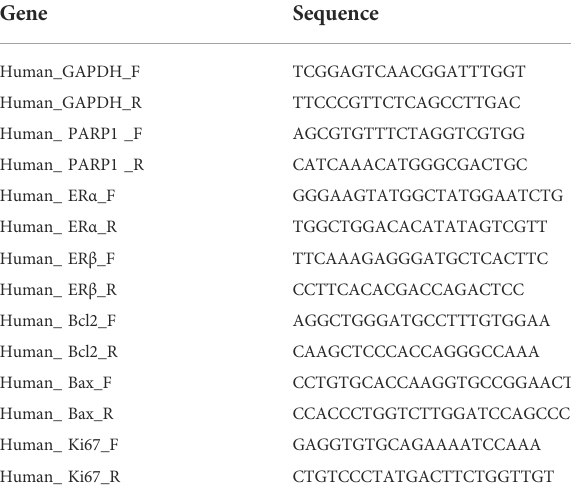
TABLE 1 Primer sequence details of the analyzed gene (F: forward primer, R: reverse Primer). Gene